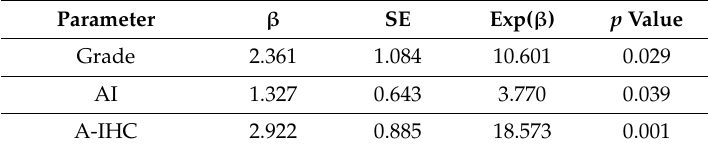
Table 4. Multivariate survival analysis using the Cox regression model in gastric tubular adenocarcinomas.